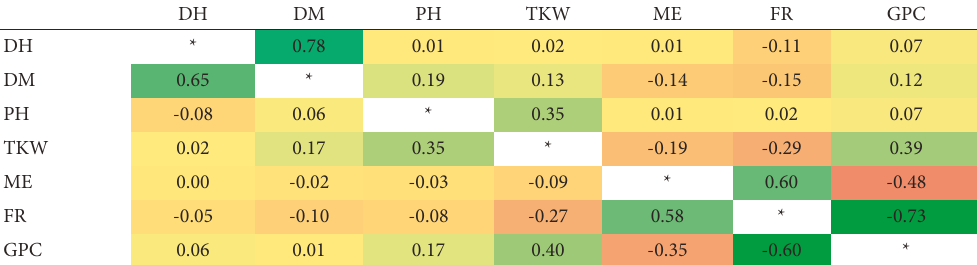
Table 8: Correlation of traits studied (genotypic correlation above diagonal).